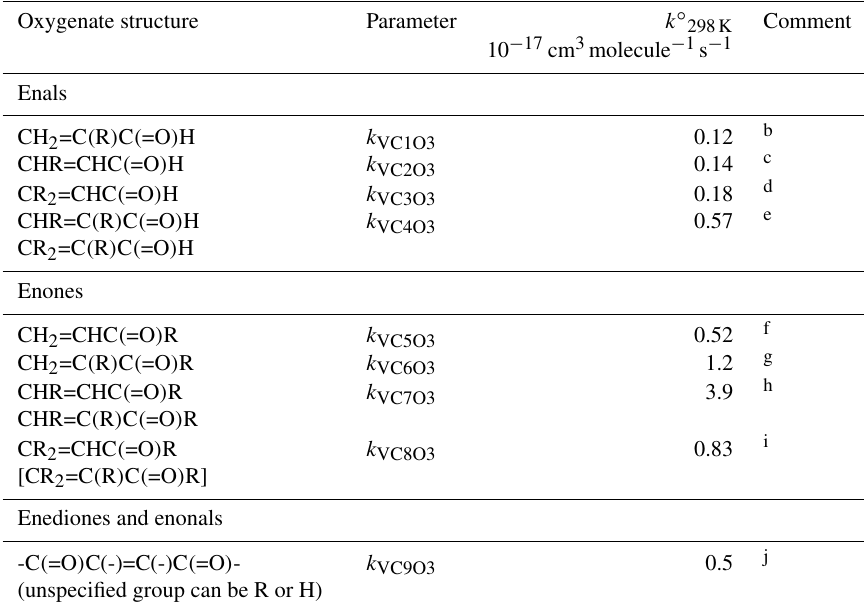
Table 6. Reference rate coefficients for O 3 addition to acyclic vinyl aldehyde and ketone structures. a